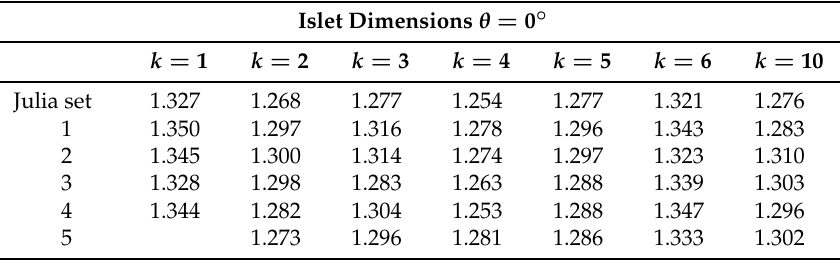
dimension of these islets.